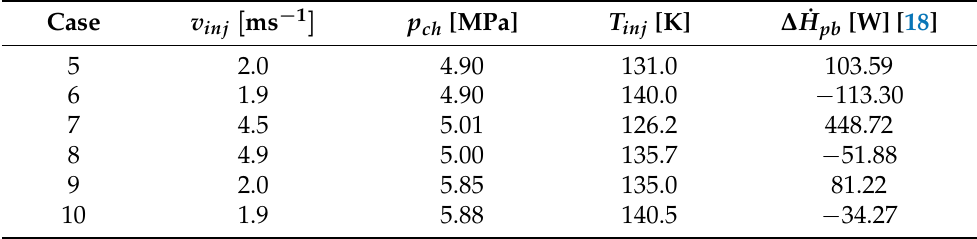
Table 5. Experimental test matrix [23].